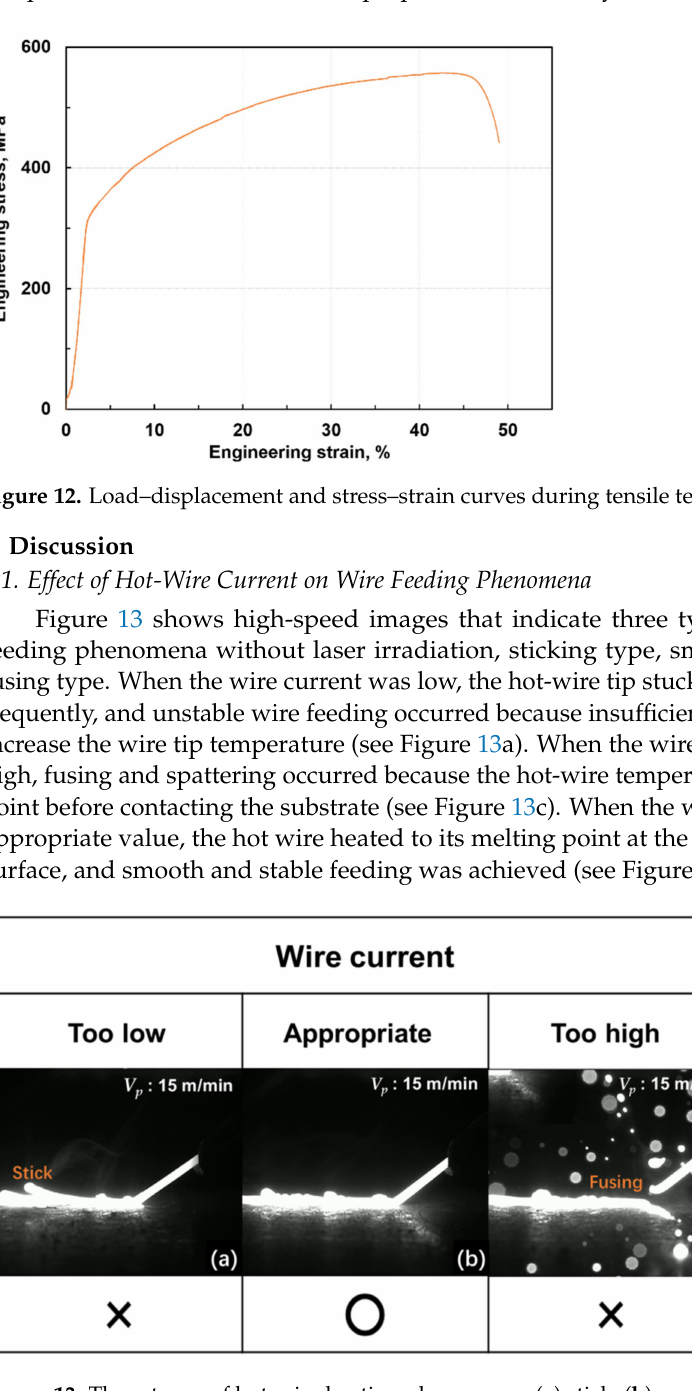
Figure 13. Three types of hot-wire heating phenomena: ( a ) stick, ( b ) smooth, and ( c ) fusing. The same tendency was confirmed for all hot-wire feeding speeds from 5 to 20